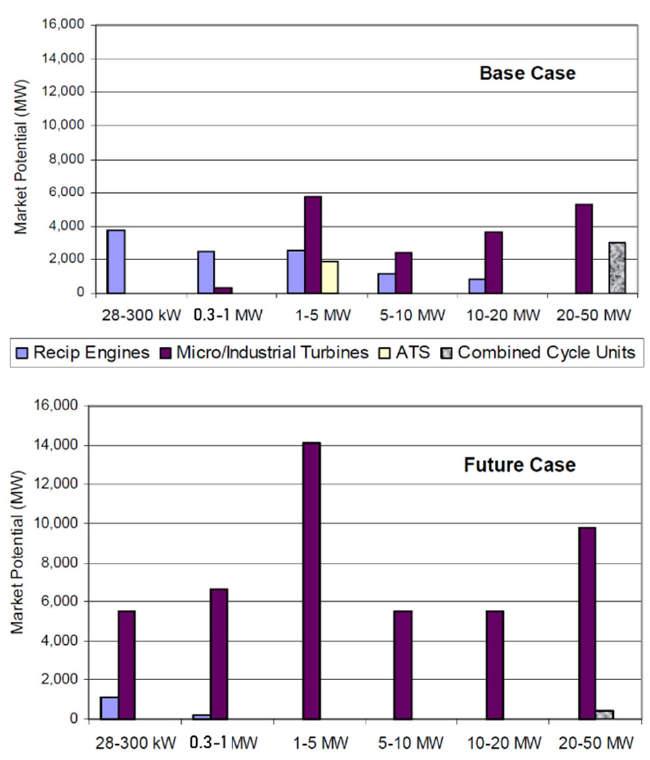
Figure 7. CHP technology market potential by unit size, base data is collected in 2002 [43].